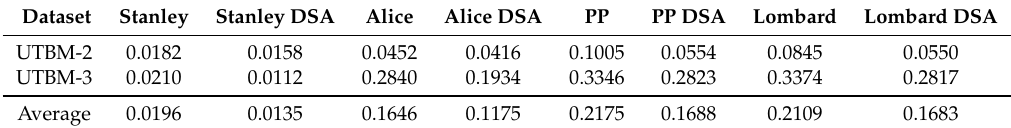
Table 1. Error comparison in zones of 30 km/h with different lateral control methods. Results are expressed in meters. DSA, Dynamic Speed Adaptation; PP, Pure